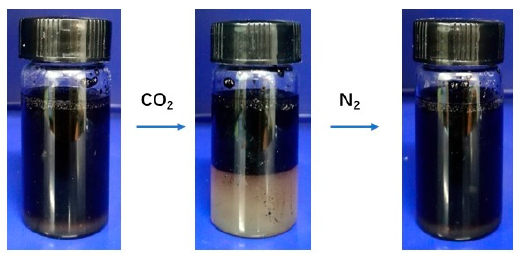
Figure 4. Reversible stability of emulsion of crude oil and aqueous solution. The aqueous solution (5 mL) contains SDS (0.012 mol · L − 1 ) and oligochitosan (0.2 wt.%). The original emulsion (left) is stable and oligochitosan does not spoil its stability. The phase separation appears with the addition of CO 2 (center). However, a stable emulsion is reformed after sparging N 2 and hand shaking (right).